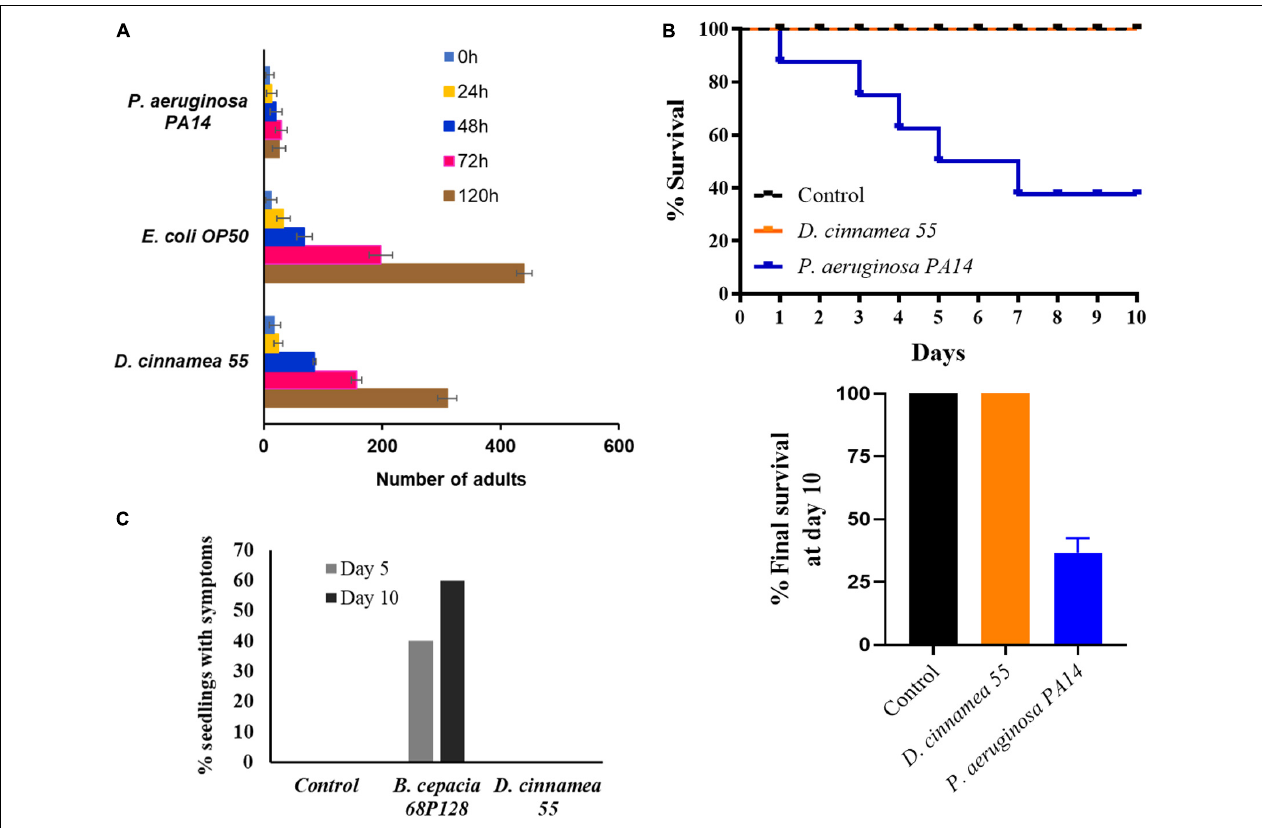
FIGURE 4 | Pathogenicity response of D. cinnamea 55. (A) Response of C. elegans fed with D. cinnamea 55 under slow-killing conditions. (B) Comparison of percent survival of G. mellonella after infection with P. aeruginosa PA14 and D. cinnamea 55. (C) Effect of D. cinnamea 55 inoculation on visual symptoms of pathology on alfalfa. B. cepacia 68P128 treatment served as the pathogen control. Values presented as mean ±